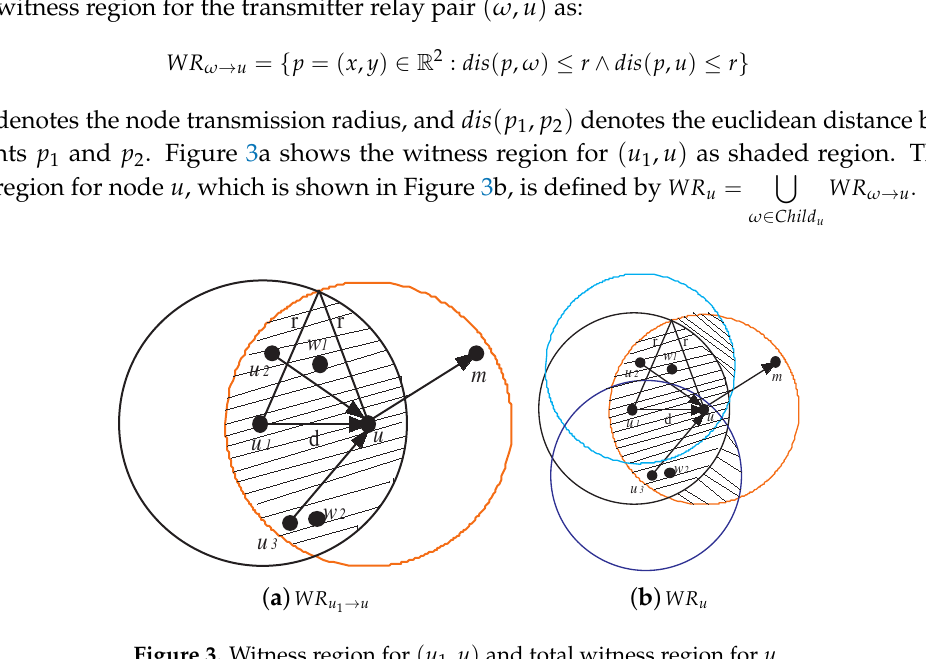
Figure 3. Witness region for ( u 1 , u ) and total witness region for u